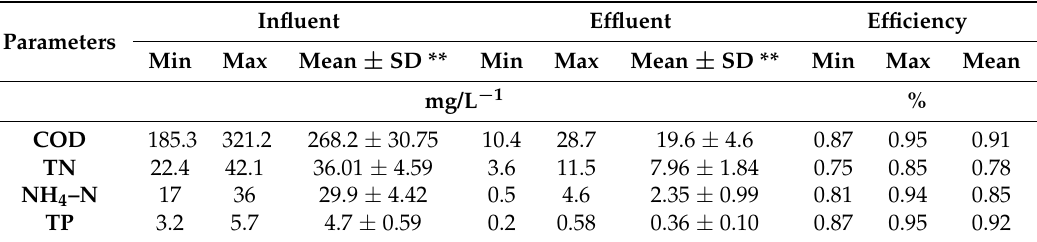
Table 4. Removal efficiencies were achieved by A2O-wetland system.